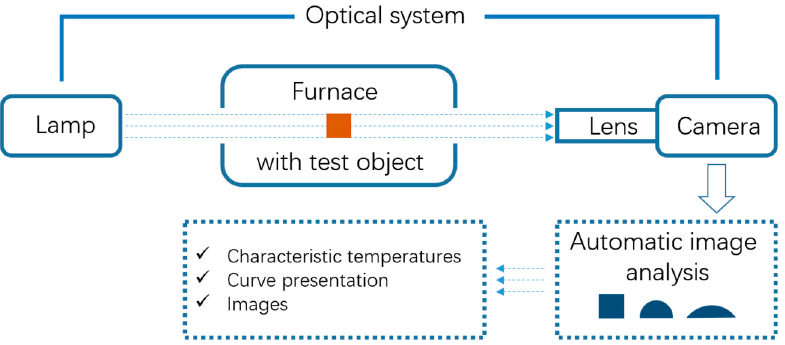
Figure 1. HSM optical system and automatic image analysis.